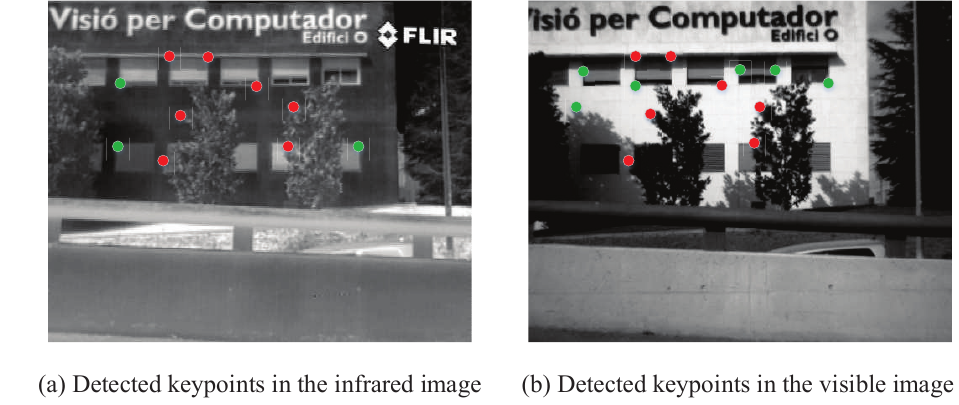
Figure 8. Illustration of the repeatable